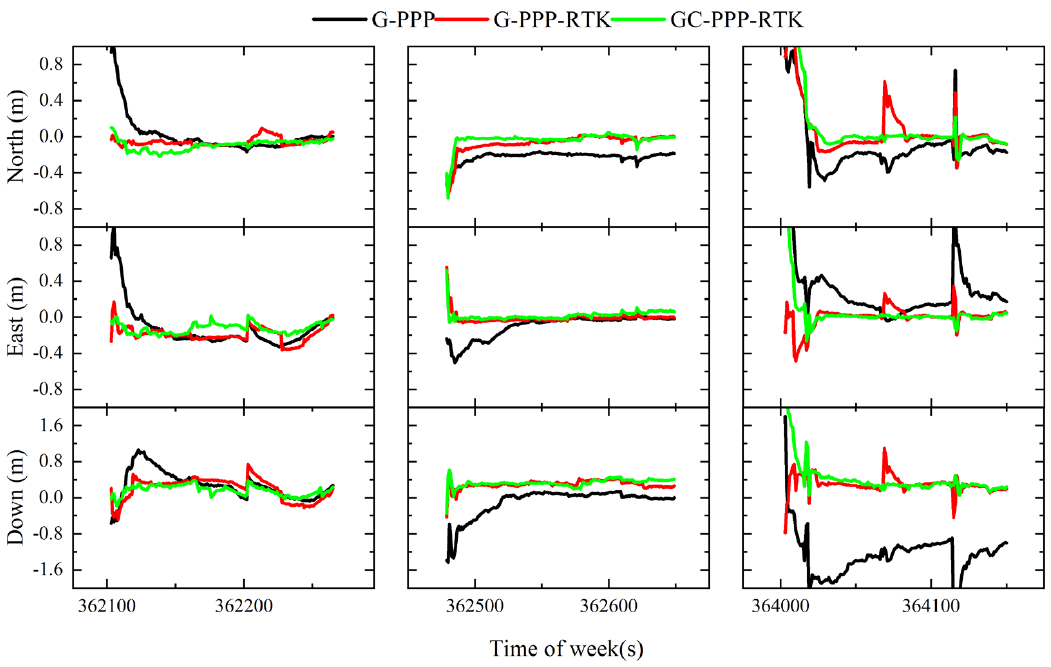
Figure 11. Convergence (left panel) and reconvergence (middle panel and right panel) of T02 in north, east, and down directions, respectively.